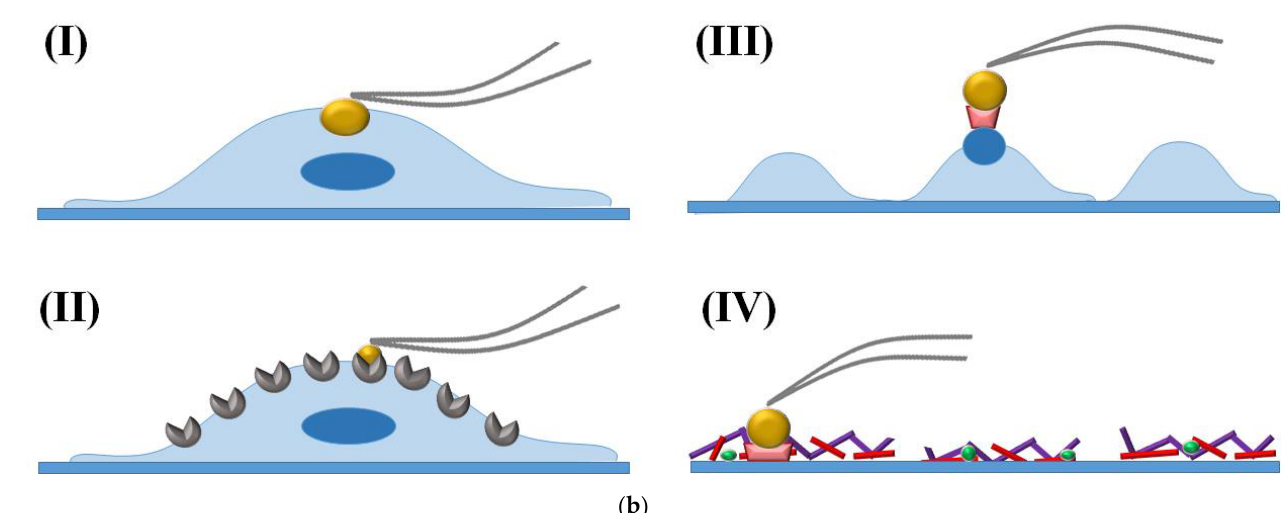
Figure 4. ( a ). Schematic diagram of AFM working principles. The AFM instrument is composed of a main probe (cantilever), a laser source, a piezoelectric material, and a quadruple photodiode detector. The AFM probe is a flexible cantilever with a sharp micro-tip that is attached at its end. The tip, which has a monomolecular point, allows for nanometer resolution imaging and the micro-cantilever is a force sensor that can detect even minute deformation of a sample, enabling very high sensitivity AFM in force measurement. ( b ). Schematic illustrations of the AFM-based biomechanical assays. (I) Indentation experiments were used to characterize the compliance of a single cell. (II) Single molecule force spectroscopy assesses interactions between a functionalized probe and the membrane receptors. Single-cell force spectroscopy was utilized to quantify (III) cell – cell adhesions and (IV) cell – substrate adhesions.